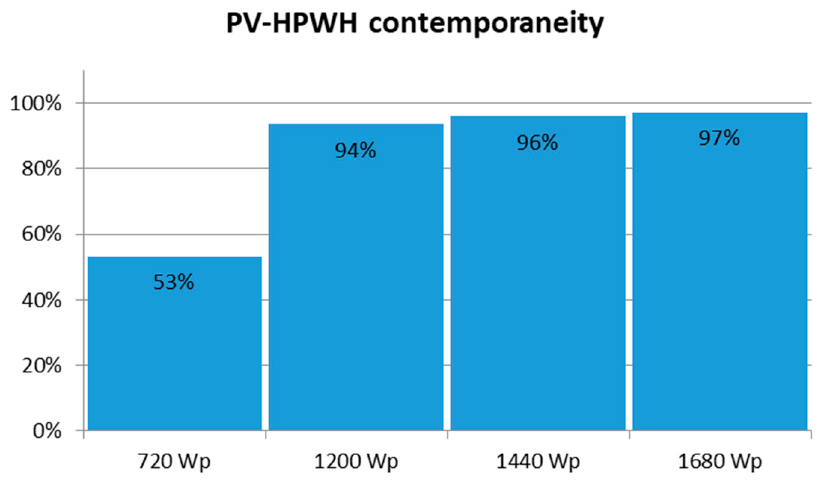
Figure 14. Contemporaneity between DHW production load and PV useful production.